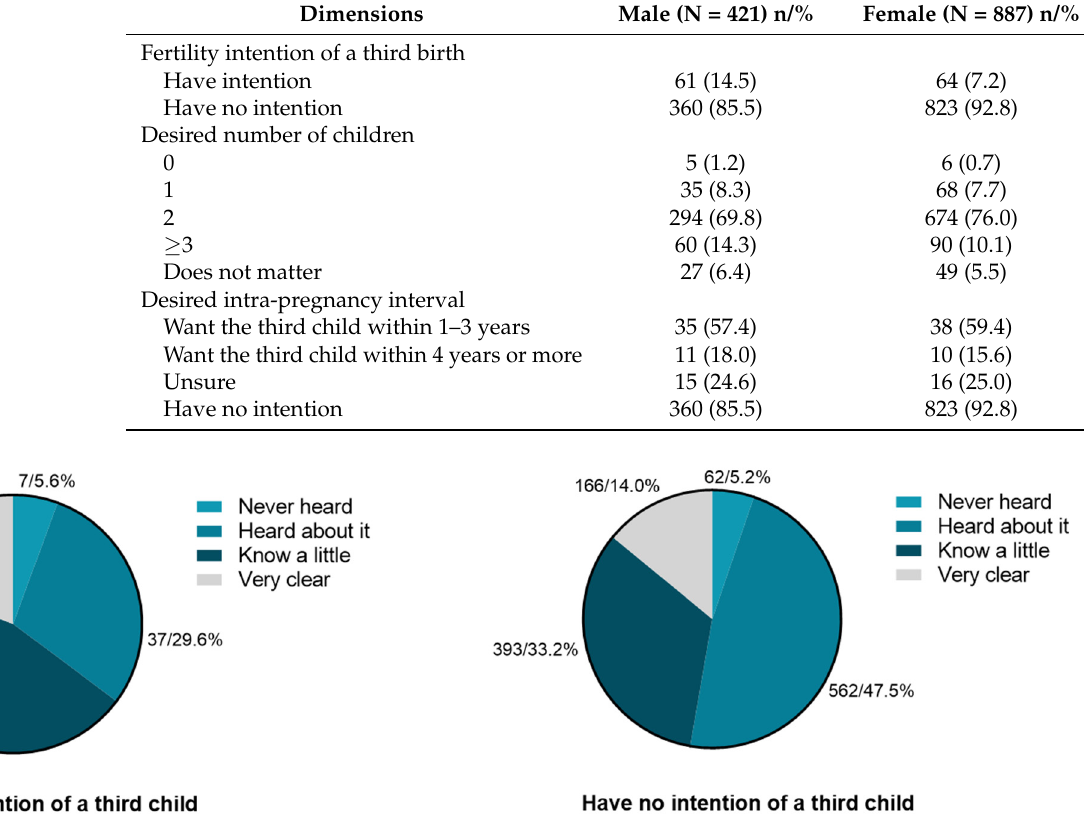
Figure 2. Public knowledge of the three-child policy.